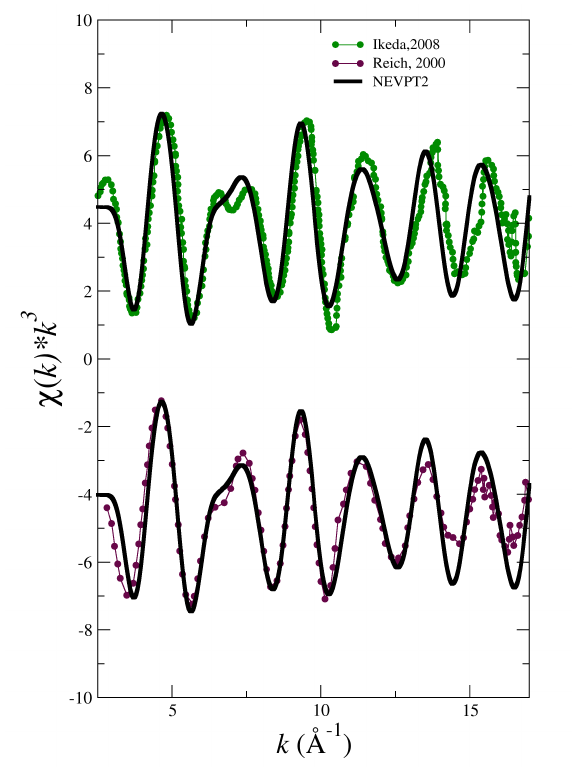
Figure 6. Simulated (black solid line) vs experimental [31,32] (dots) L III -edge k 3 -weighted EXAFS spectra for NpO + . The simulated spectra is obtained using the NEVPT2-level interaction potential 2 developed for the monovalent neptunyl cation in